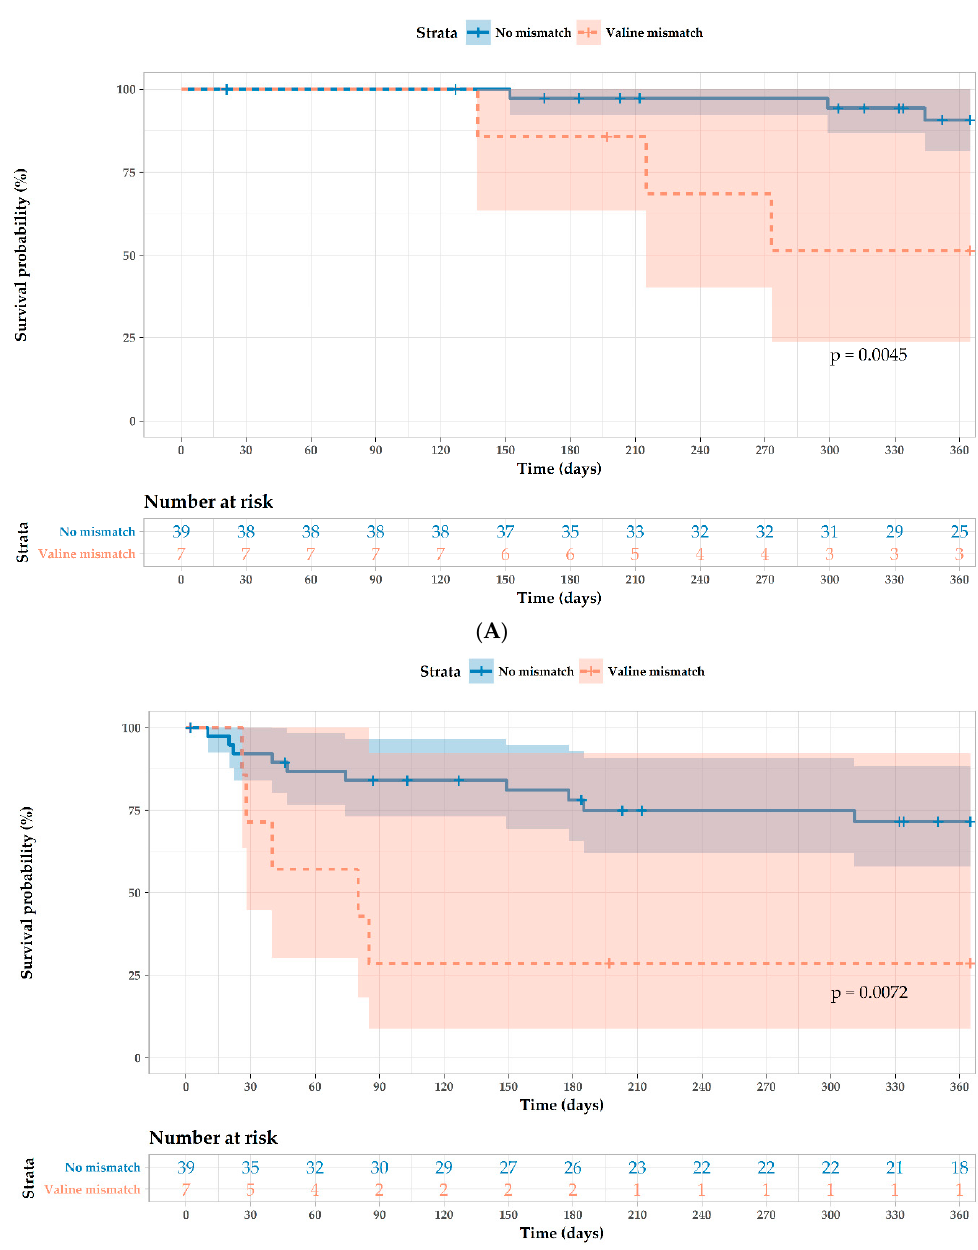
Figure 1. Impact of MICA-129Val/Met on survival following simultaneous pancreas and kidney transplantation. ( A ) Effect of MICA-129-Val mismatch (recipient Met/Met and donor Met/Val or Val/Val) in patients with cytomegalovirus infection at one year post-transplantation. ( B ) Effect of MICA-129-Val mismatch in patients with kidney acute rejection in one year post-transplantation. Table 2. Univariate and multivariate Cox regression analysis of individual covariates and their impact on the risk of cytomegalovirus infection.